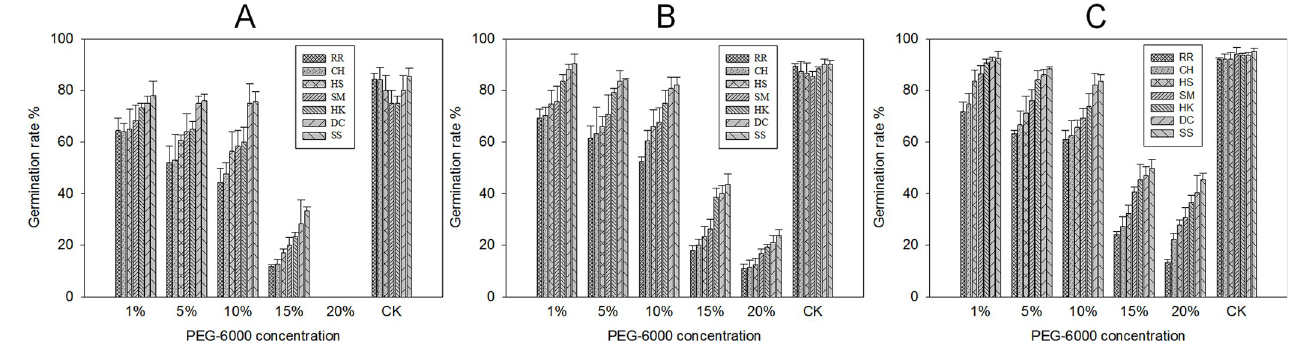
Fig 1. Germination rate (%) of the seven E . crusgalli biotypes under five PEG-6000 concentrations at different time periods. E . crusgalli germination rate (%) under five PEG-6000 concentrations at (A) 48 hours, (B) 72 hours, and (C) 96 hours of treatment. Data are expressed as least square means ± standard error.